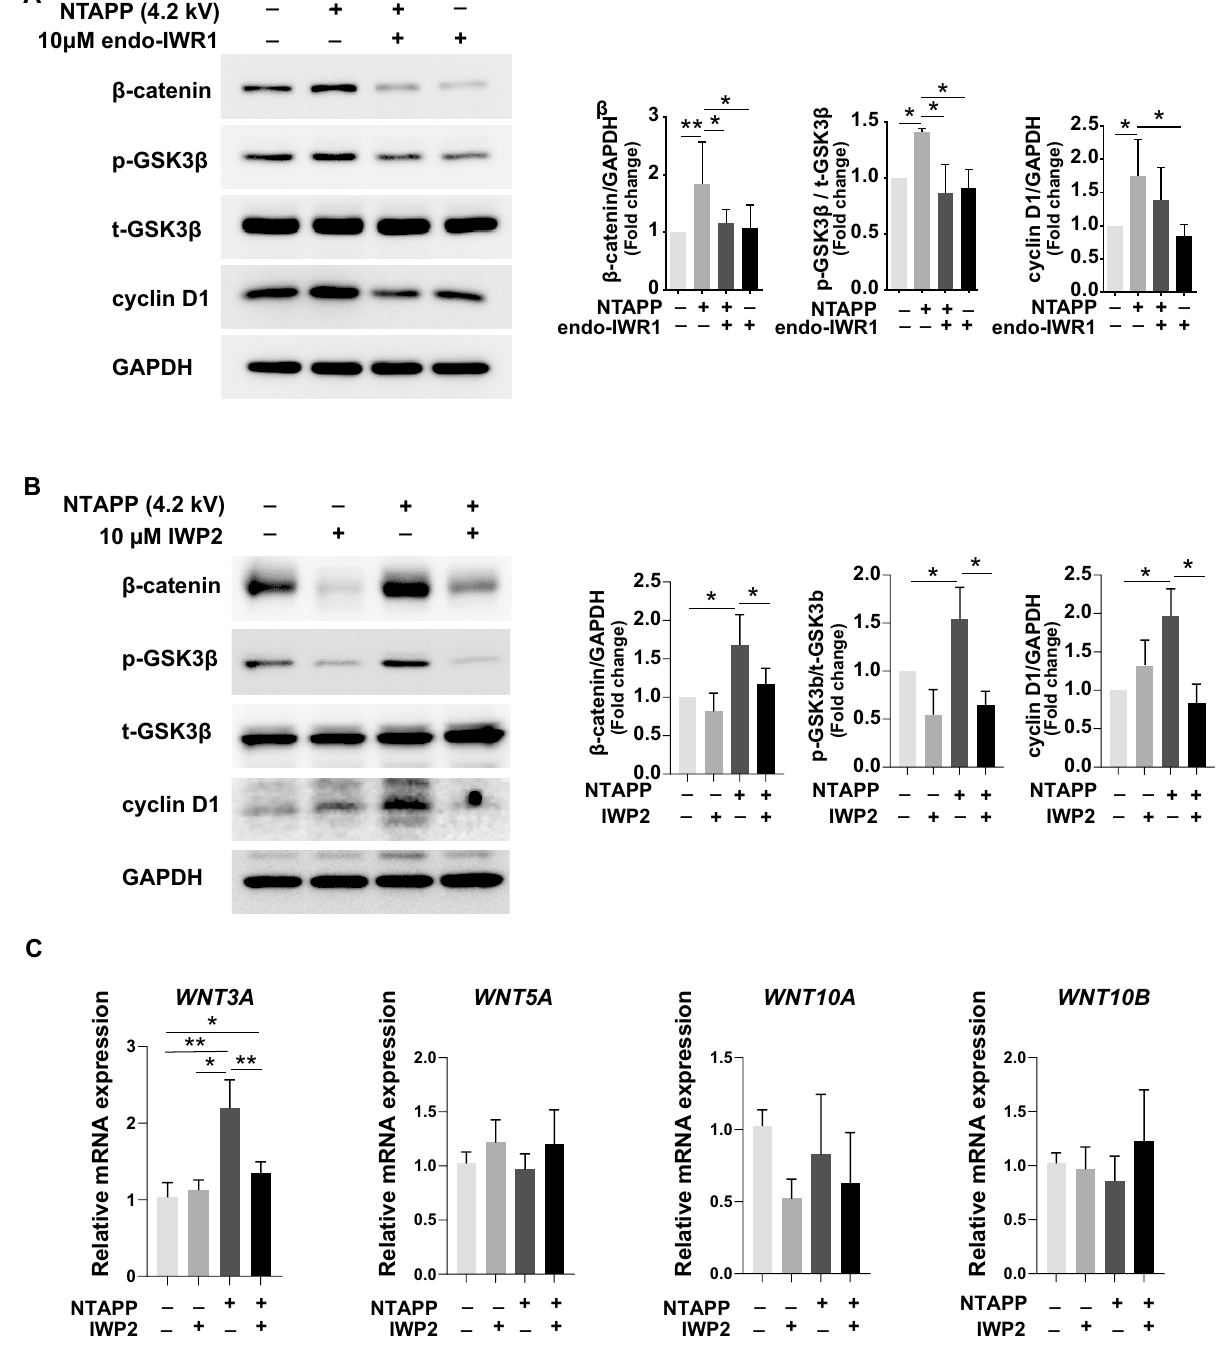
Figure 2. Mode of activation of canonical Wnt/β-catenin signaling by NTAPP. ( A ) Western blots for β-catenin, GSK3β, and cyclin D1 in hDP cells after NTAPP treatment combined with either endo-IWR1 (10 μM) pre- treatment or control. ( B ) Western blots for β-catenin, GSK3β, and cyclin D1 in hDP cells after NTAPP treatment combined with either IWP2 (10 μM) pre-treatment or control. ( C ) qRT-PCR for Wnt ligands after NTAPP treatment with or without pre-treatment of 10 μM IWP2. Cells were treated with NTAPP (4.2 kV) for 1 min, and then incubated for 24 h before harvesting. p values were determined by one-way ANOVA. * p < 0.05, ** p < 0.01 (vs. control). The original images of blots for ( A , B ) are available in Supplementary